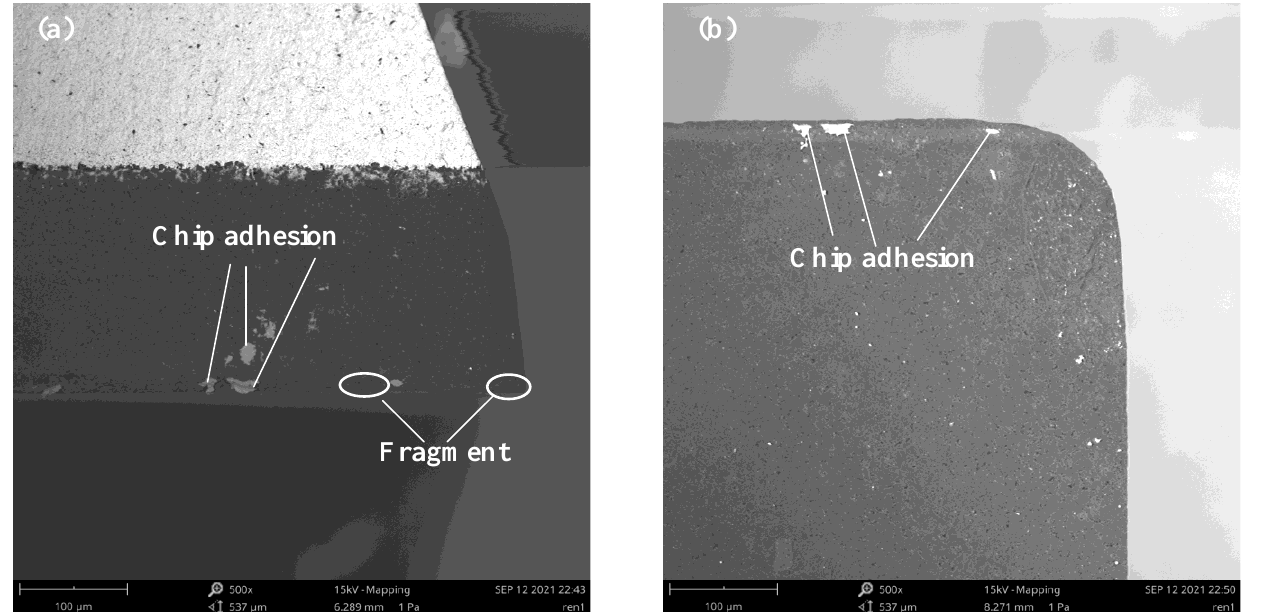
Figure 8. PCD tool wear of UVAM : ( a ) flank face; ( b ) rake face.